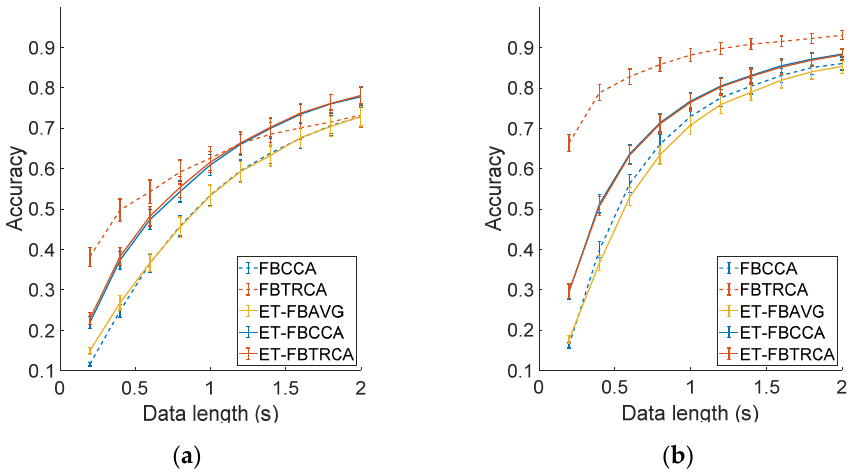
Figure 10. The classification accuracy of the three electrode-transfer (ET) methods and the FBCCA and FBTRCA methods for ( a ) wet-to-dry transfer and ( b ) dry-to-wet transfer. The error bars repre- sent standard